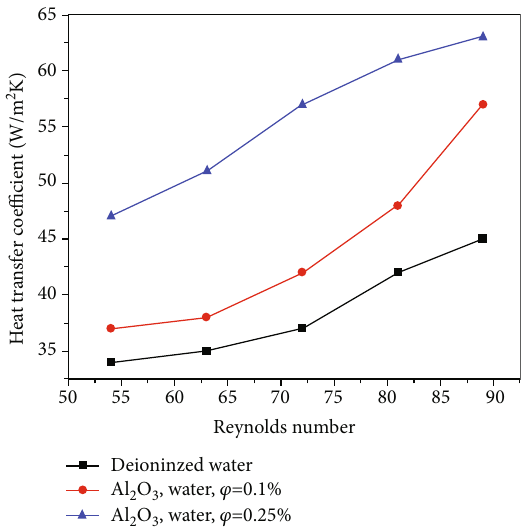
Figure 6: Heat transfer coe ffi cient vs. Reynolds number for heat input of 15 W.